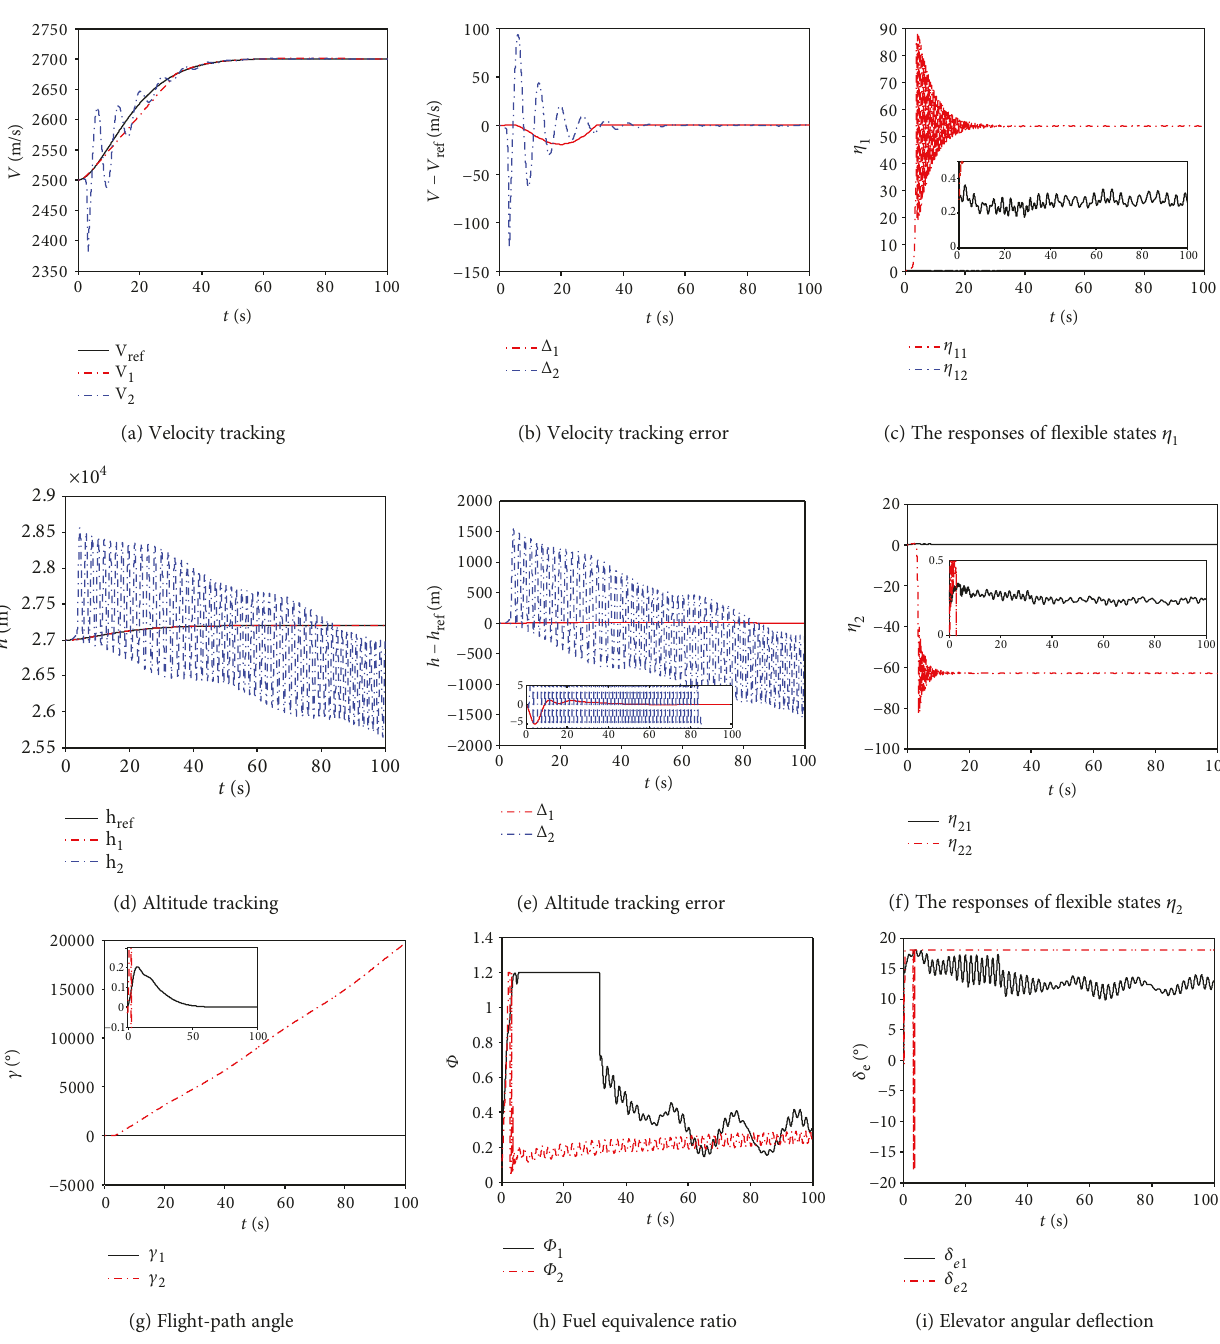
Figure 3: Simulation result of Case